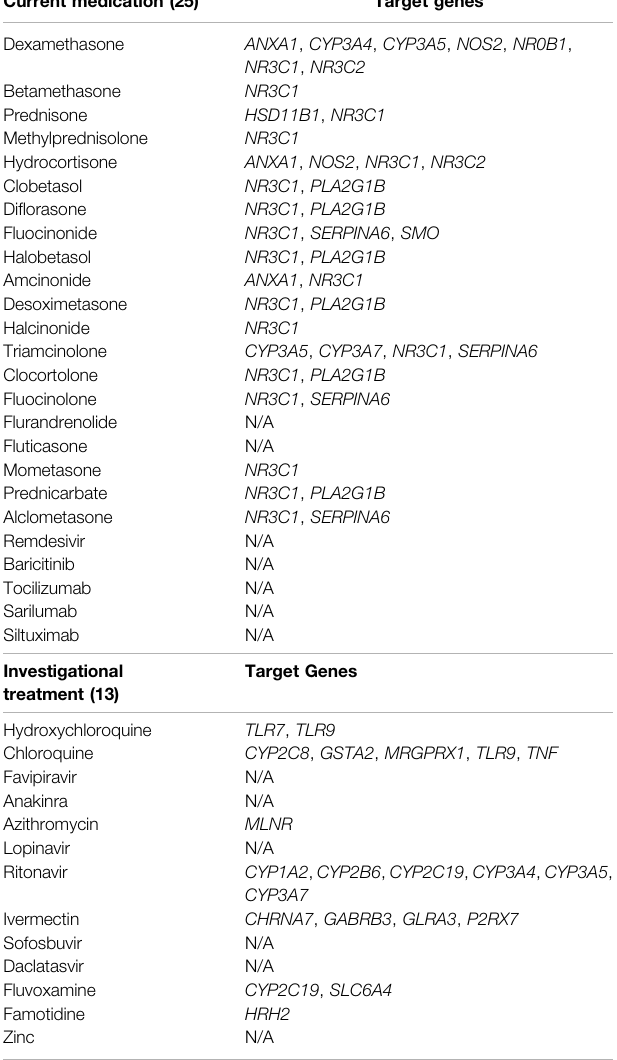
TABLE 1 | Current COVID-19 drugs and their target